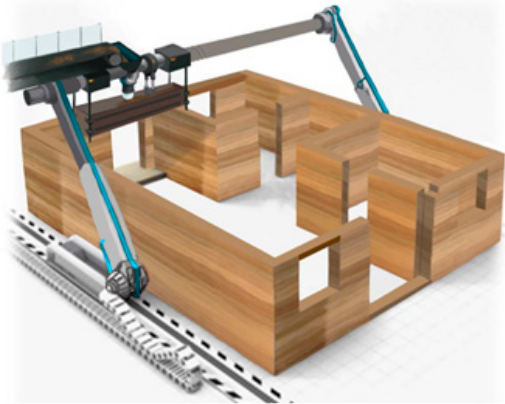
Figure 1. Schematic diagram of the autonomous rammed earth construction method.